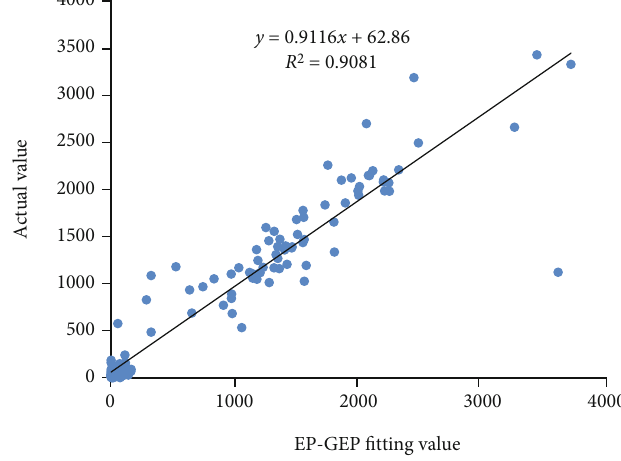
Figure 3: Regression graph of actual oil production and EP-GEP fi tting